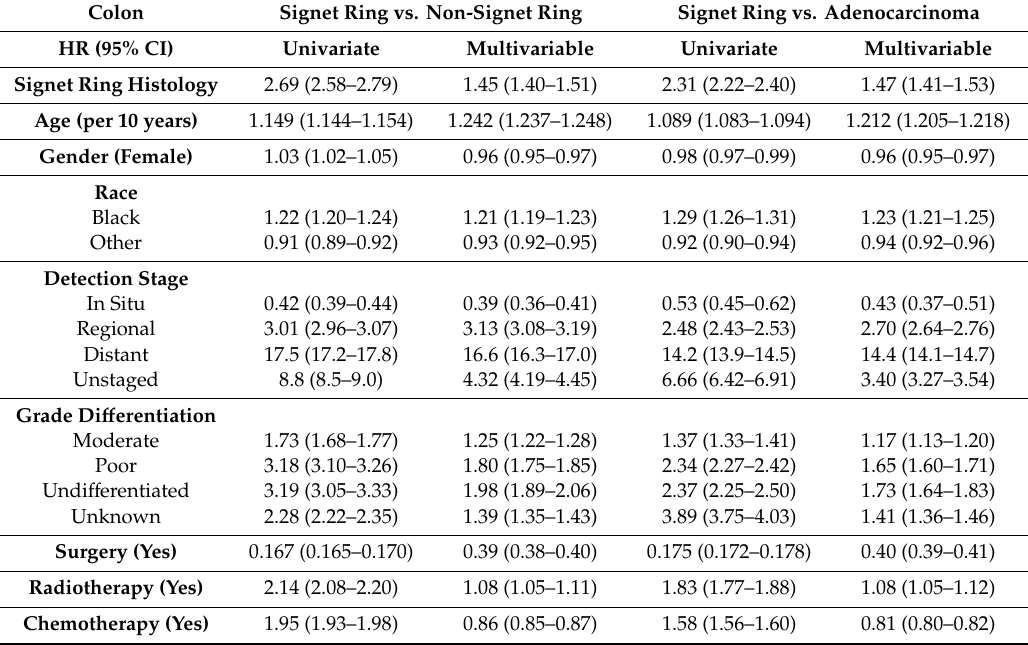
Table 4. Derived univariate and multivariable Cox-proportional hazard ratios (HR) of mortality for colon cancers.